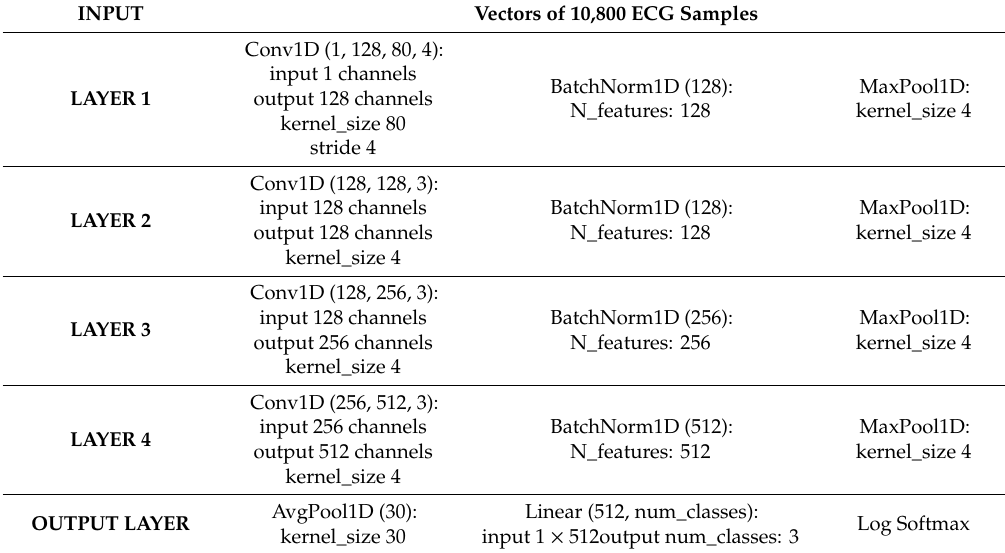
Table 2. The structure of the proposed